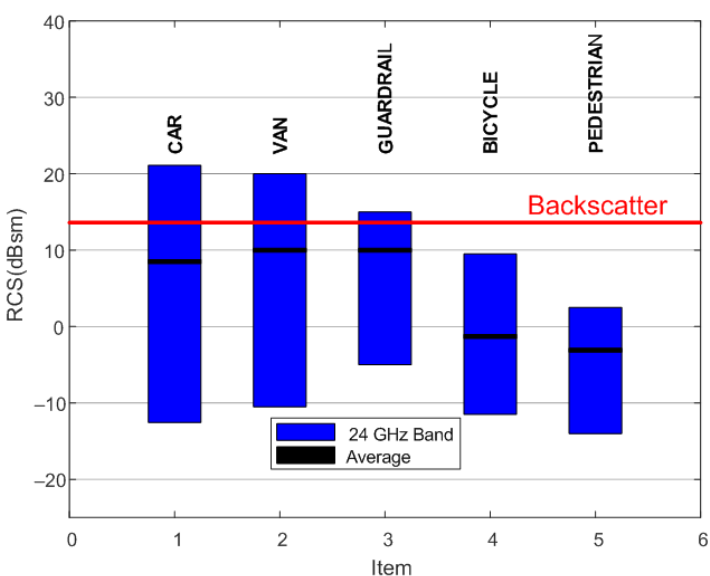
Figure 11. RCS level of different relevant road objects such as a car, a small van, a guardrail, a bicycle, and a pedestrian at 24 GHz band.The peak differential radar cross section for the prototype of modulated backscatter is shown as a red